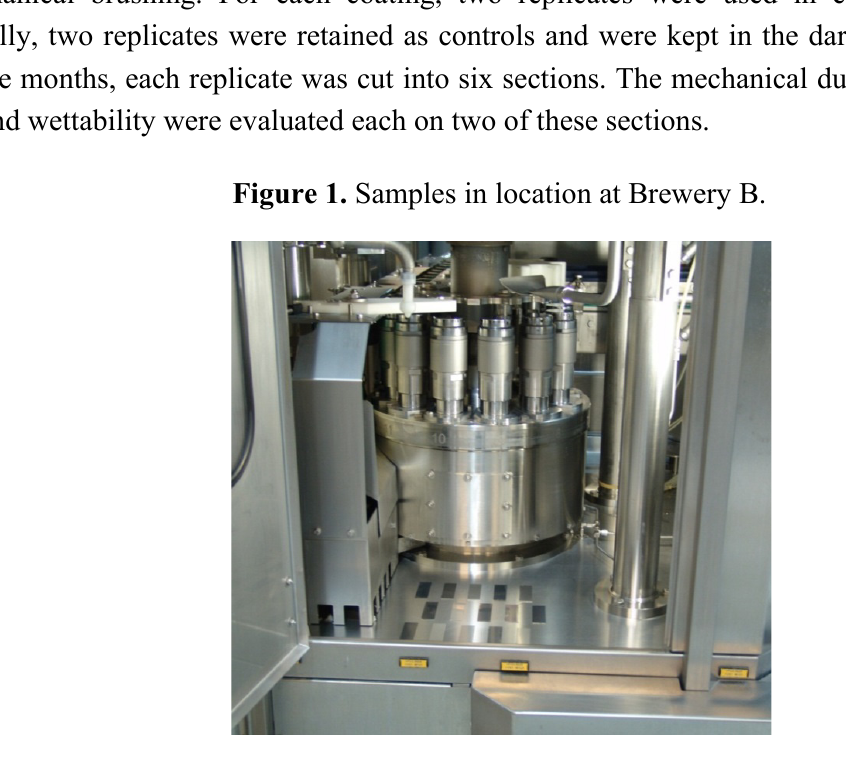
Table 2. Coatings evaluated in process tests (for a period of three